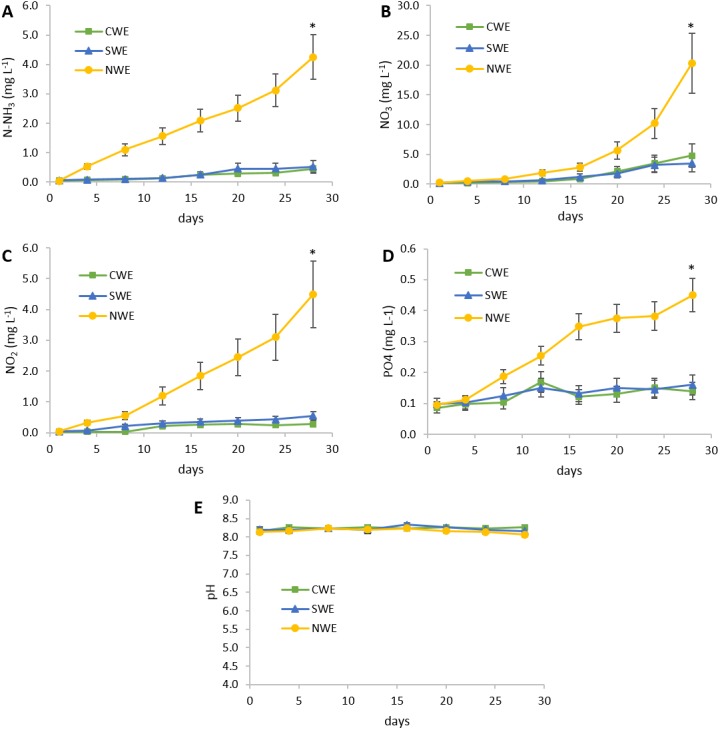
Water quality parameters during experiment 1.CWE, 50% daily clean water exchange; SWE, 50% daily exchange with water bioremediation by Ulva lactuca; NWE, no water exchange. (A) Water variations of total ammonia nitrogen (N-NH3); (B) Water variations of nitrate (NO3); (C) Water variations of nitrite (NO2); (D) Water variations of phosphate (PO4); (E) Water variations of pH. Values are given as mean ± SD of triplicate determinations, (∗) are significantly different (p < 0.05).